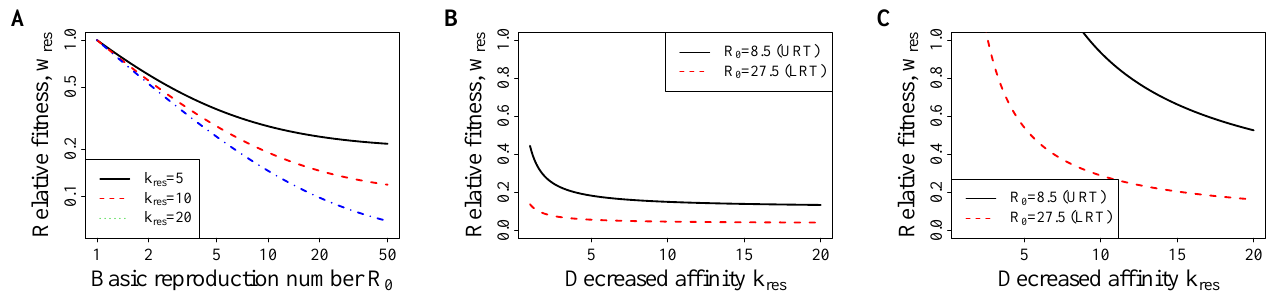
Figure 6. Fitness requirements for selection of resistant mutants. ( A ) Shows the minimal resistance with which newly emerging resistant mutants can be selected for, dependent on the baseline R 0 in a patient, as obtained with Equation (8). The x -axis shows R 0 (estimated between 4.3 and 42.1 depending on body compartment and patient). The y -axis shows the relative fitness costs. ( B , C ) show the minimal fitness with which newly emerging resistant mutants can be selected for, depending on the decrease in drug–target affinity, as obtained with Equation (7). The x -axis shows the parameter k res , which describes the factor by which drug–target binding is decreased by a resistance mutation, the y -axis shows the relative fitness. The black line shows results for the upper respiratory tract and the red line for the lower respiratory tract; ( B ) shows the results for the standard treatment; ( C ) Shows the results for a 1350 mg/8 h